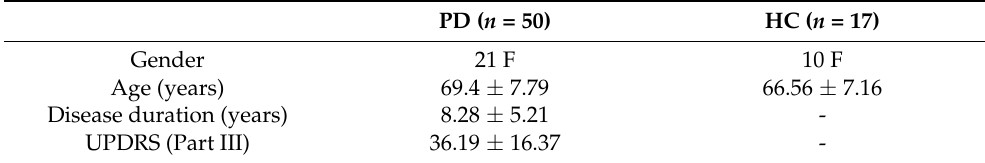
Table 1. Demographic data of participants (PD = subjects with Parkinson’s disease; HC = healthy control